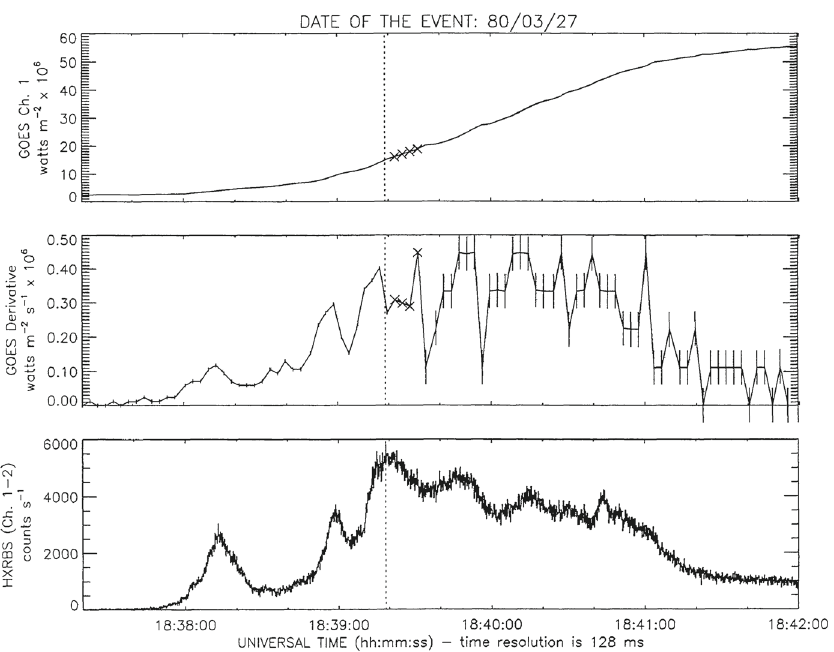
Fig. 12 The time derivative ( middle ) of the soft X-ray flux ( top , observation by the GOES satellite) correlates in 80% of the flares with the hard X-ray flux ( bottom , observation of HXRBS on the SMM satellite). This is an example of what is called the Neupert effect. Image reproduced with permission from Dennis and Zarro (1993), copyright by